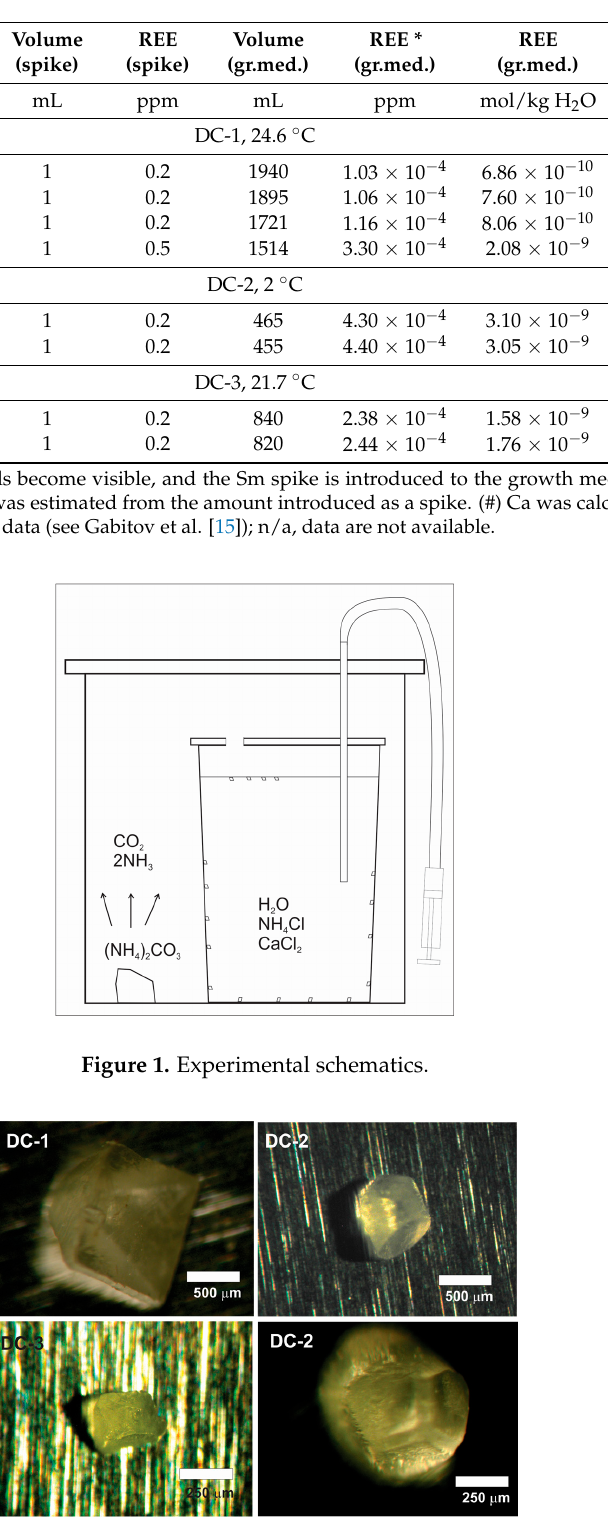
Table 1. Experimental setup and fluid data at the moment of REE addition.